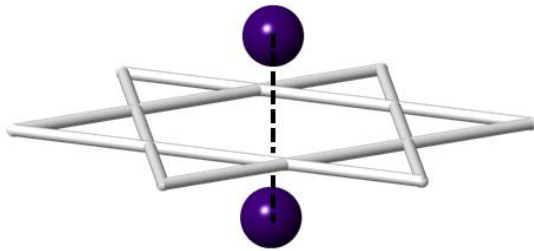
Figure 2. Hexagonal pore through the kagome lattice; the dashed line links the two opposing Cs + ions.